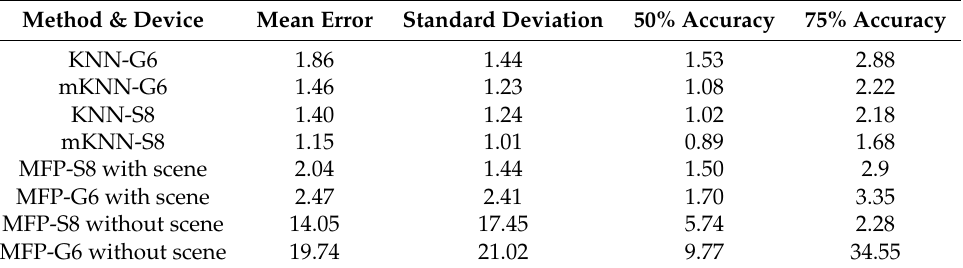
Figure 10. Localization results for S8 and G6. Table 2. Error statistics for KNN and